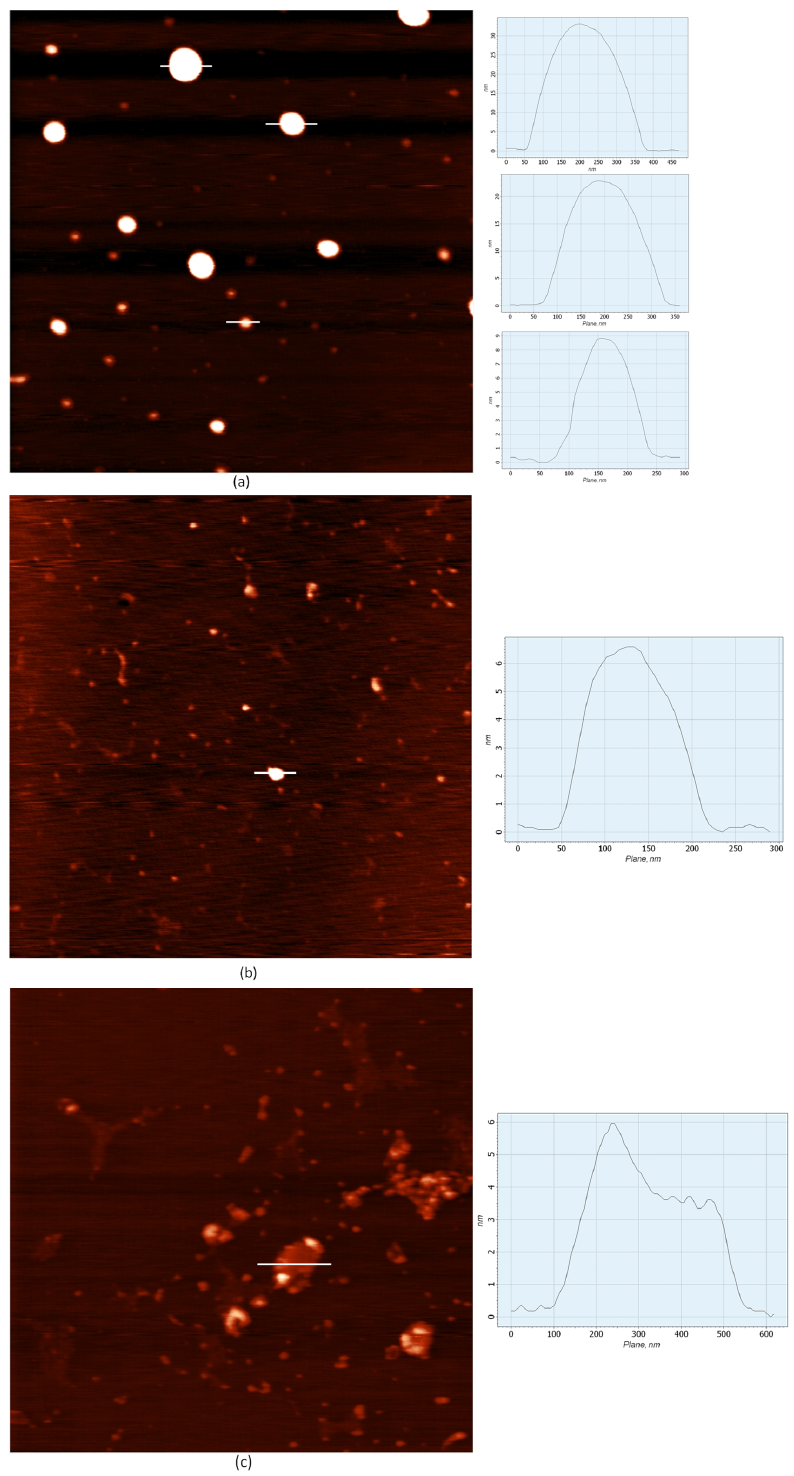
Figure 2. AFM images of LNPs and lipoplexes with mRNA formed in water. Experimental conditions: mi-ca, scanning area of 4 × 4 µ m (512 × 512 pixels). ( a ) LNP sample S1 diluted to 1:20 with water; ( b , c ) LNP lipoplex (sample S1) and mRNA (N/P = 15) diluted to 1:20 with water. ( a ), the cross- sections from top to bottom, half-height: 16, 10.5 and 4.6 nm, half-width at half maximum: 115, 90 and 50 nm, ( b ), half-height 3.3 nm, half-width at half maximum 59 nm, ( c ), half-height 1.8, half-width at half maximum 180 nm. Representative samples from multiple scan fields are